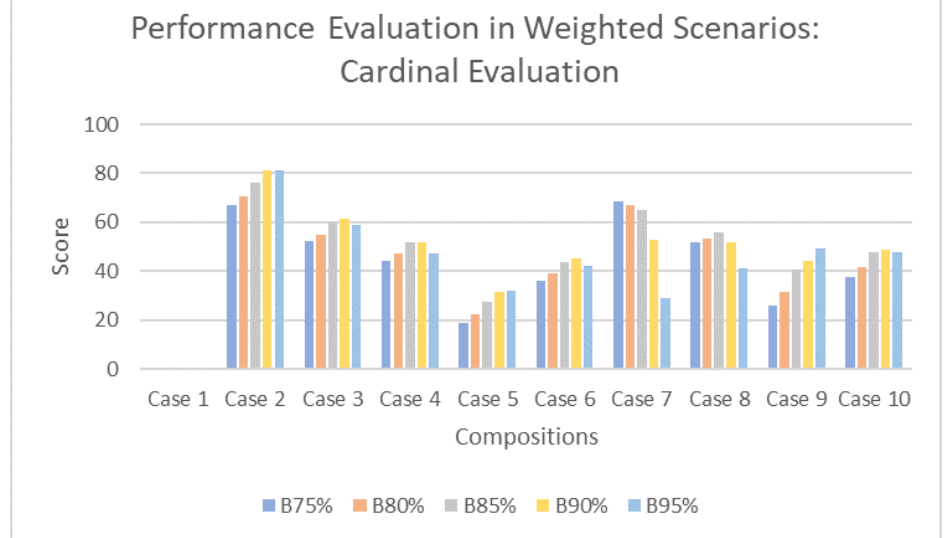
Figure 10. Identification of the Best Distribution of RD Contracts: Alternative